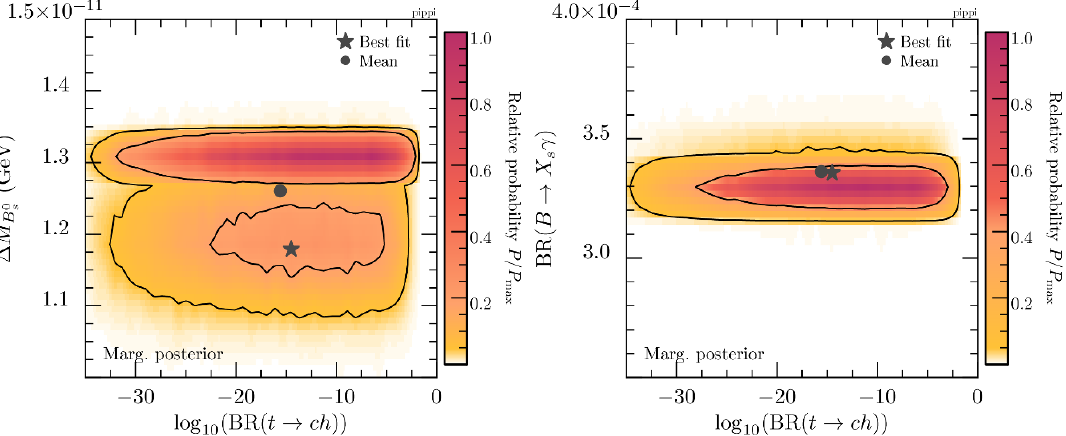
Figure 12 . Di(cid:11)erent observables and parameters versus log mass splitting. Right : radiative B decays.